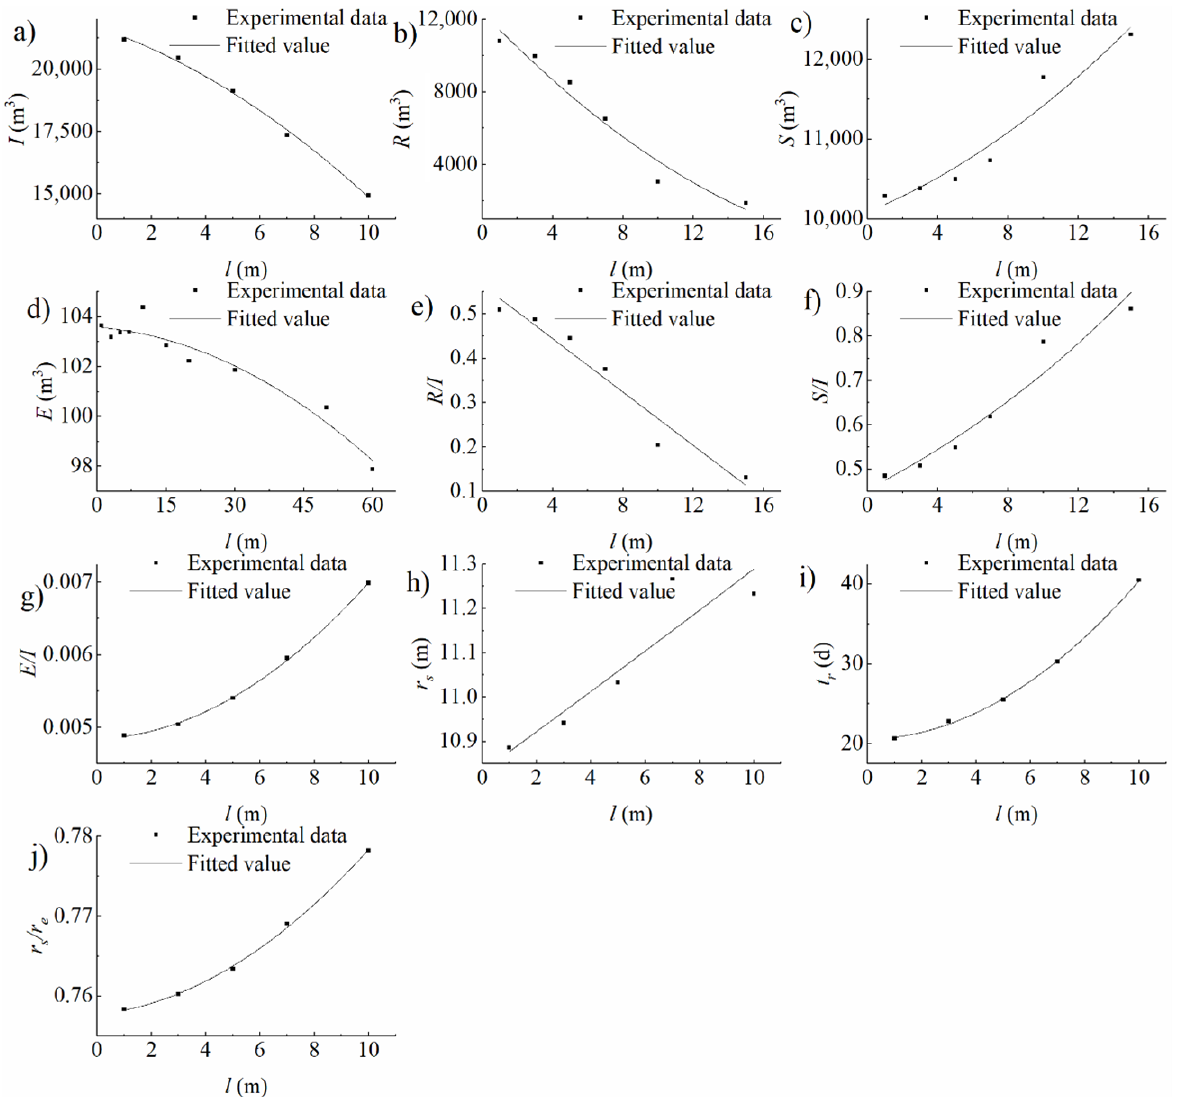
Figure 8. The variations with an increment in l when the depth is 5 m. (( a ) variation of I; ( b ) variation of R; ( c ) variation of S; ( d ) variation of E; ( e ) variation of R/I; ( f ) variation of S/I; ( g ) variation of E/I; ( h ) variation of r s ; ( i ) variation of t r ; ( j ) variation of r s /r e .).